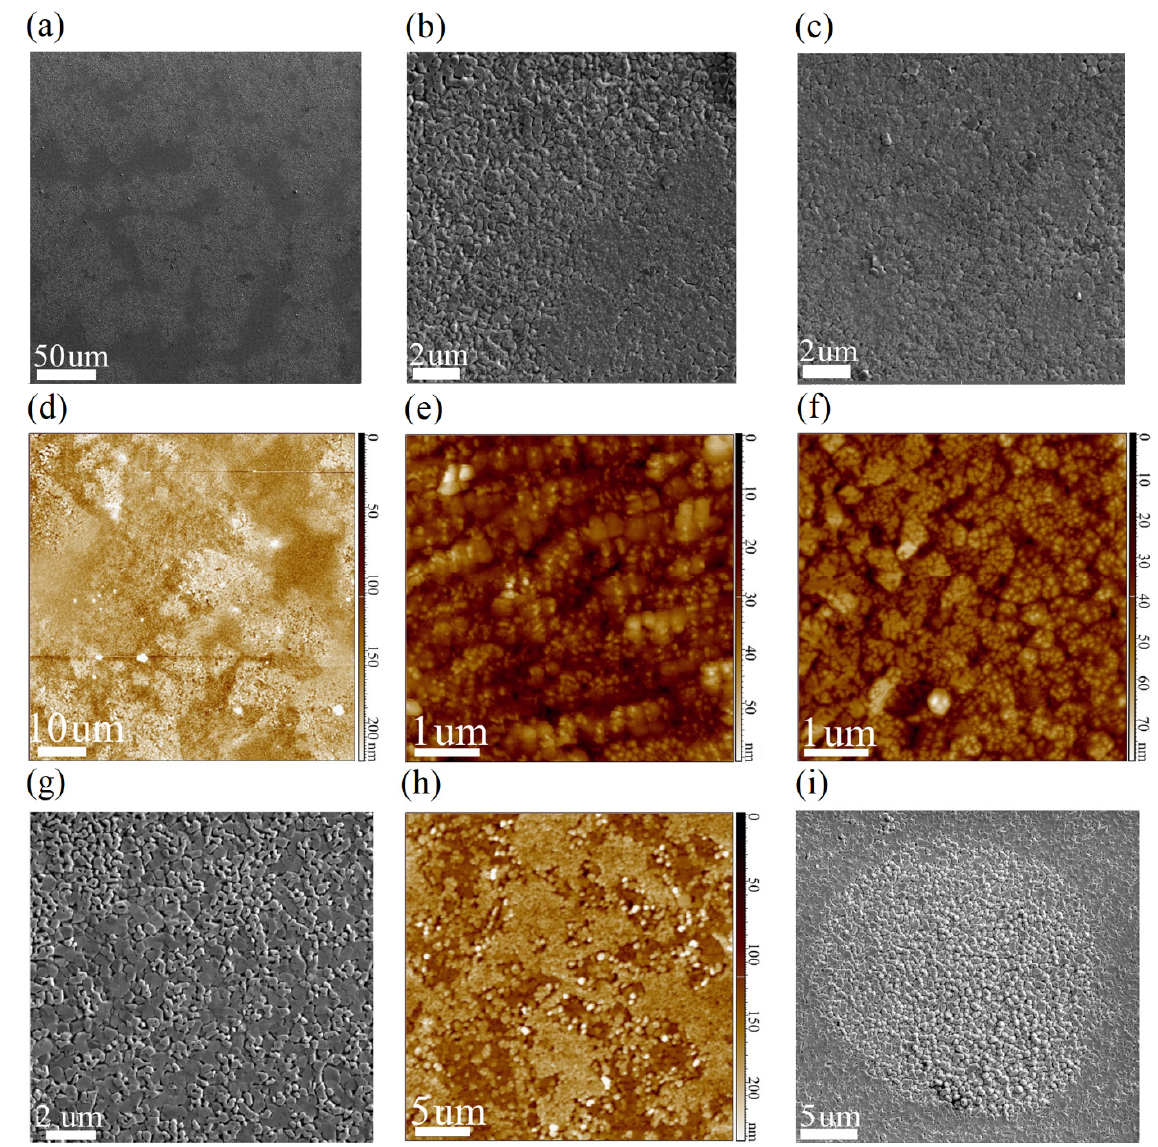
Figure 6. SEM and AFM images of the surface of GaN/AlN (0001) film grown on SLG ( a , b , d , e ) with regions of FLG ( c , f ) and on MLG ( g – i ) in random regions of the samples. In the PA-MBE process, epitaxial GaN/AlN layers grow directly on the graphene- coated regions; in other places, the nitride layers are polycrystalline. The formation of polycrystalline GaN/AlN occurs due to the low surface mobility of the adatom and rare nucleation sites. These regions possess increased reactivity and therefore facilitate nucleation of AlN. The improvement in the quality of the GaN layers in the sections of FLG indicates that the density of AlN cores correlates with the density of defects in graphene and its root-mean-square roughness. This correlates well when comparing the growth of GaN/AlN on graphene with different numbers of layers (Figure 6).